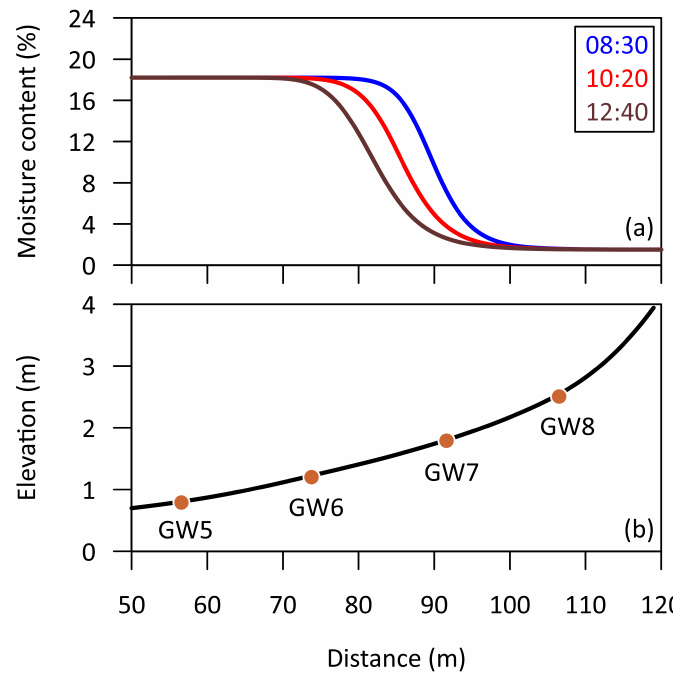
Figure 11. ( a ) Predicted surface moisture content w (cid:48) s at the three observational time intervals during falling tide on 6 October versus cross-shore distance x , compare to Figure 7a. ( b ) contains the campaign-averaged bed elevation z versus cross-shore distance x with the location of the upper 4 GWs. Predictions in ( a ) resulted from predicted groundwater elevations (Equation (1)) and the soil–water retention curve (Equation (3)) with w res = 1.5%, w sat = 18.2%, α = 3.18 m − 1 and n = 5.47 (Figure